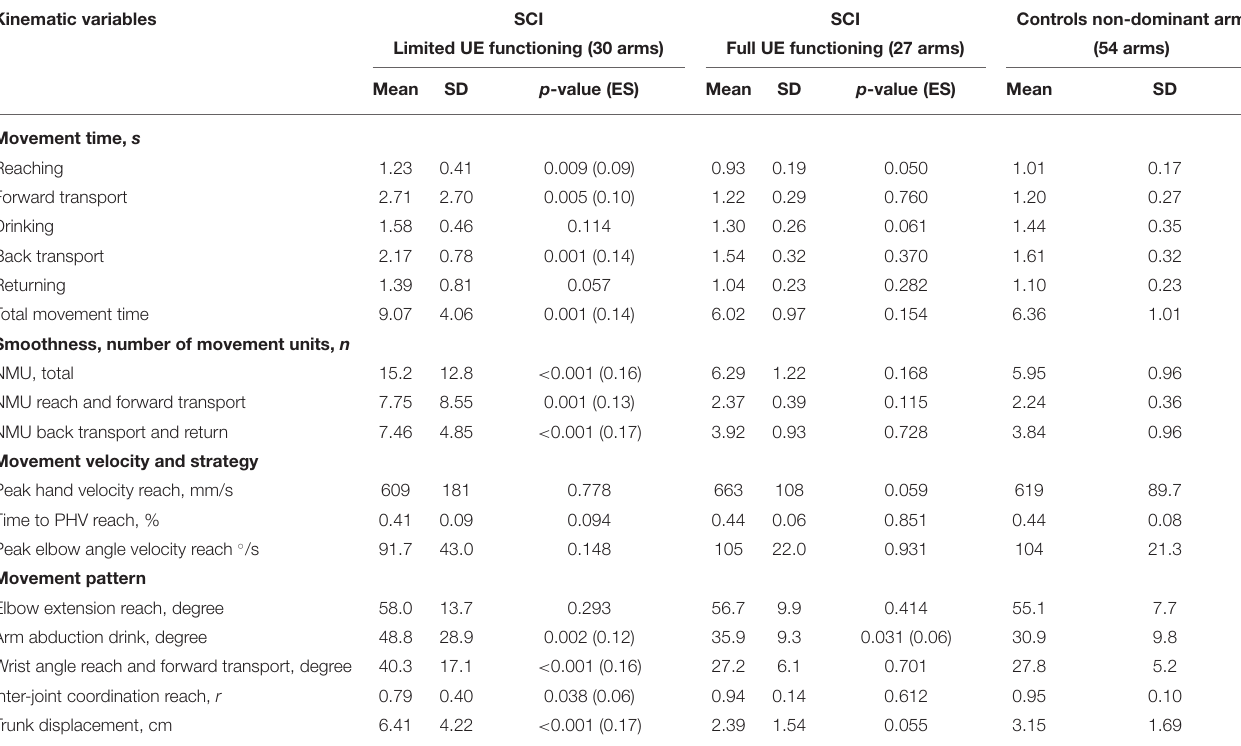
TABLE 2 | Kinematic variables of the drinking task for limited and full upper extremity functioning groups in SCI, and non-disabled controls. Kinematic